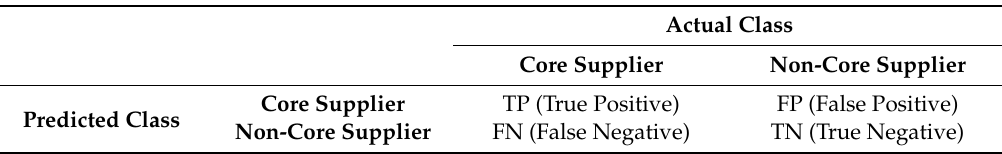
Table 2. Confusion